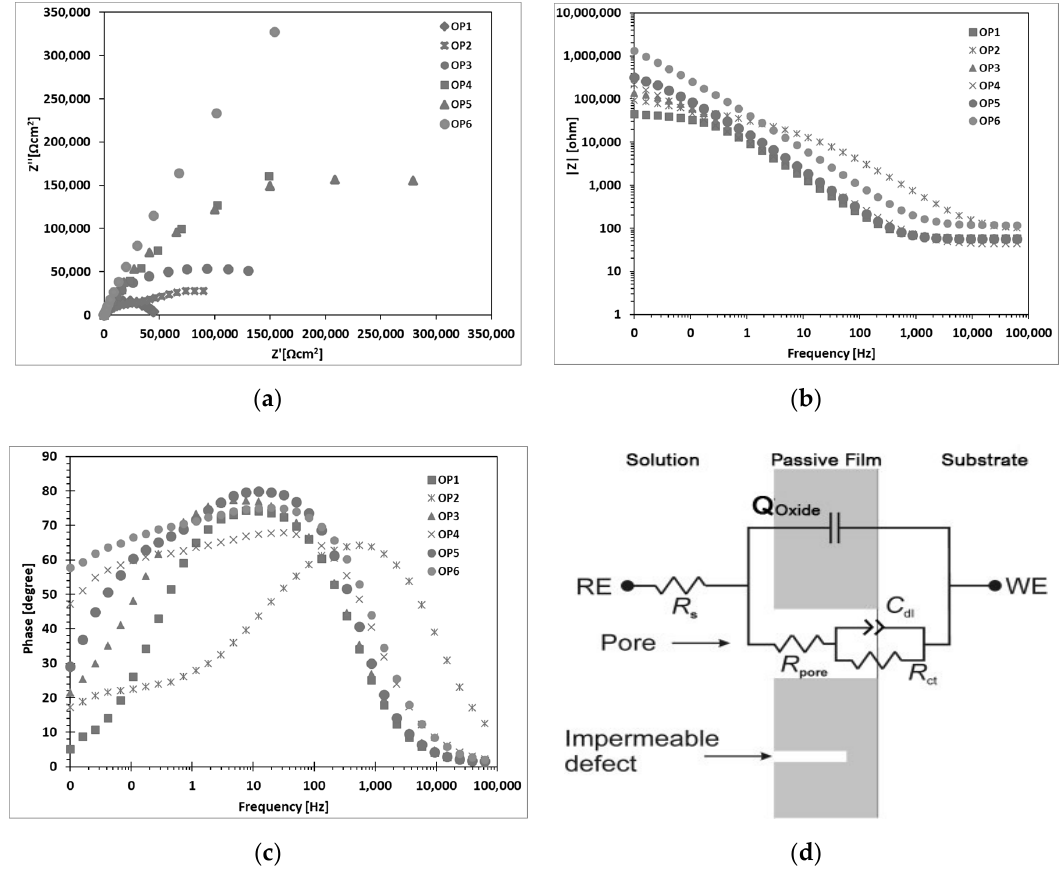
Figure 6. Electrochemical impedance spectra (EIS) of OPH variants in 3.5 wt. % NaCl solution ( a ) Nyquist diagram ( b ) Bode phase, ( c ) Bode modulus and ( d ) equivalent circuit models for the impedance spectra. Table 2. Electrochemical parameters of OP samples obtained from fitting the electrochemical impedance spectra in Figure 6.